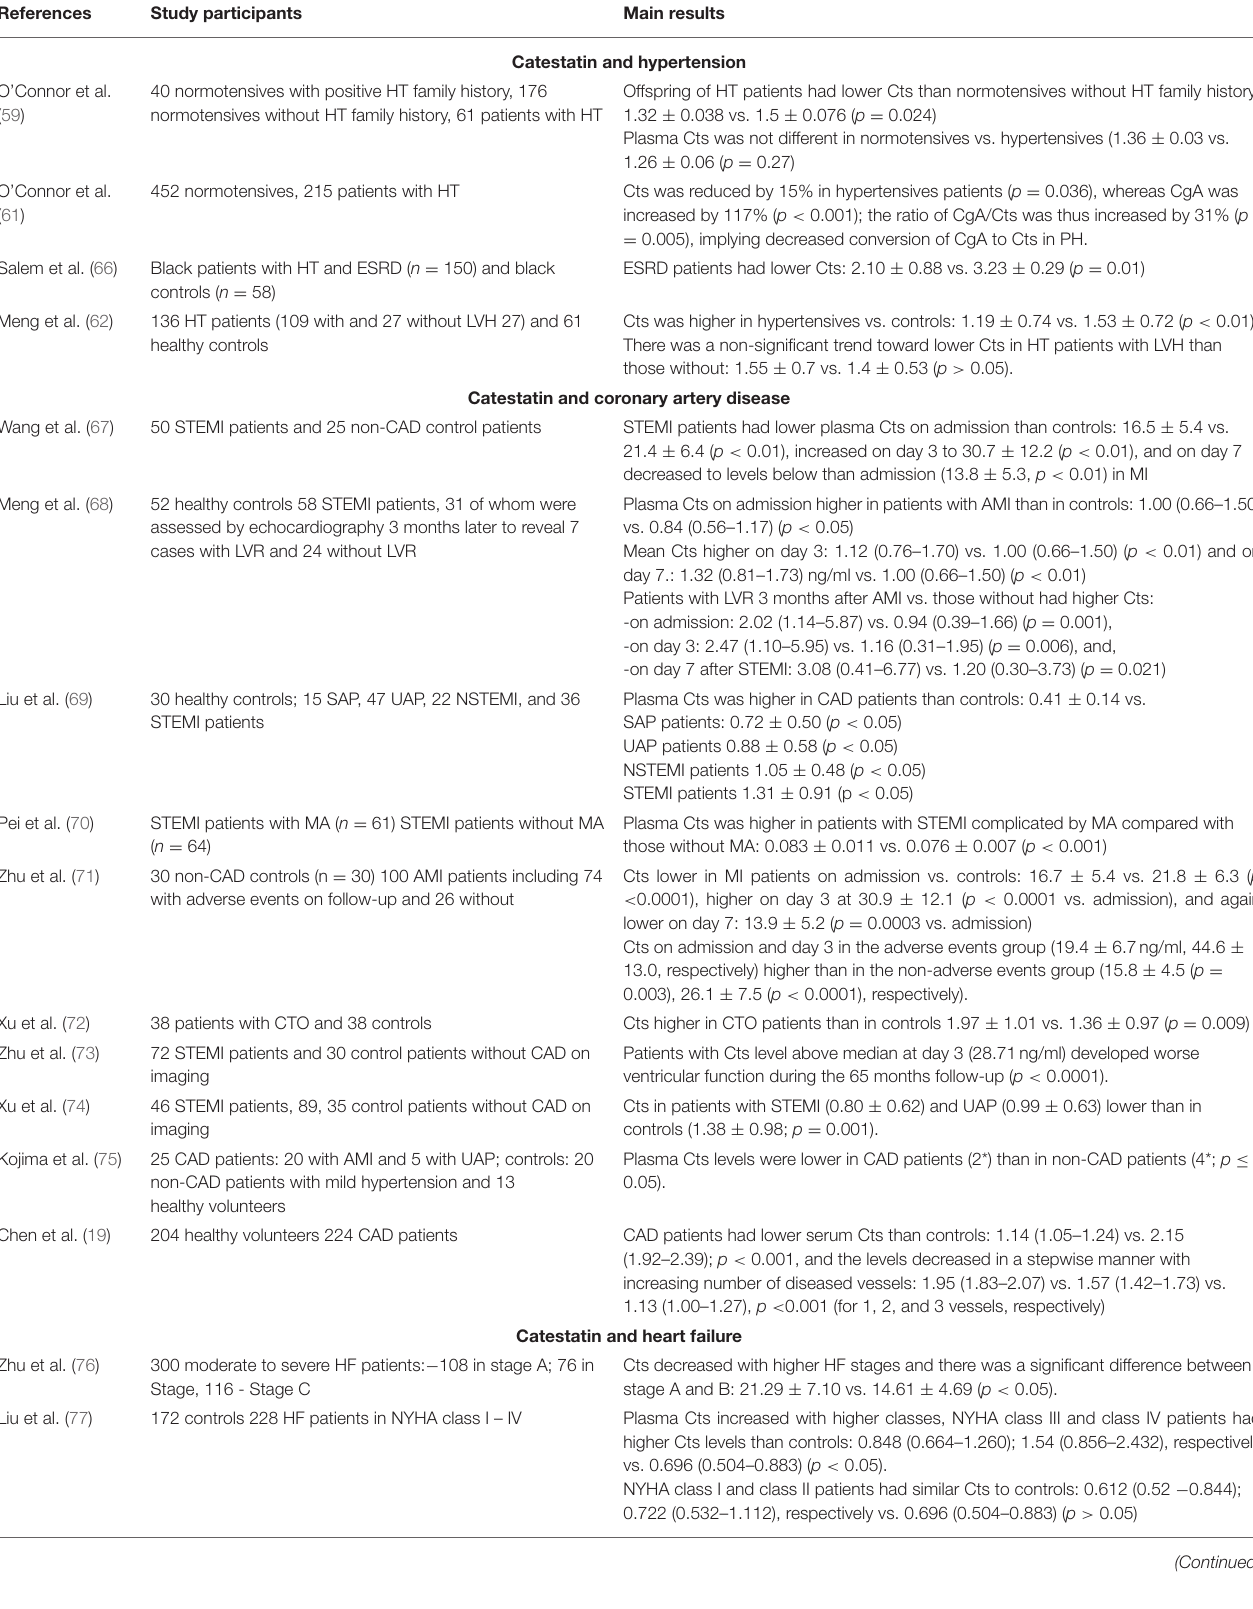
TABLE 1 | Clinical studies concerning